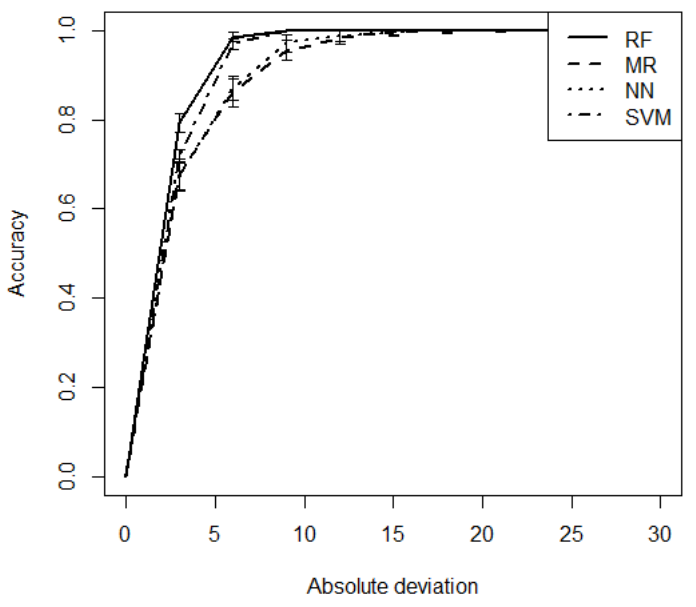
Figure 7. REC curve comparison of different